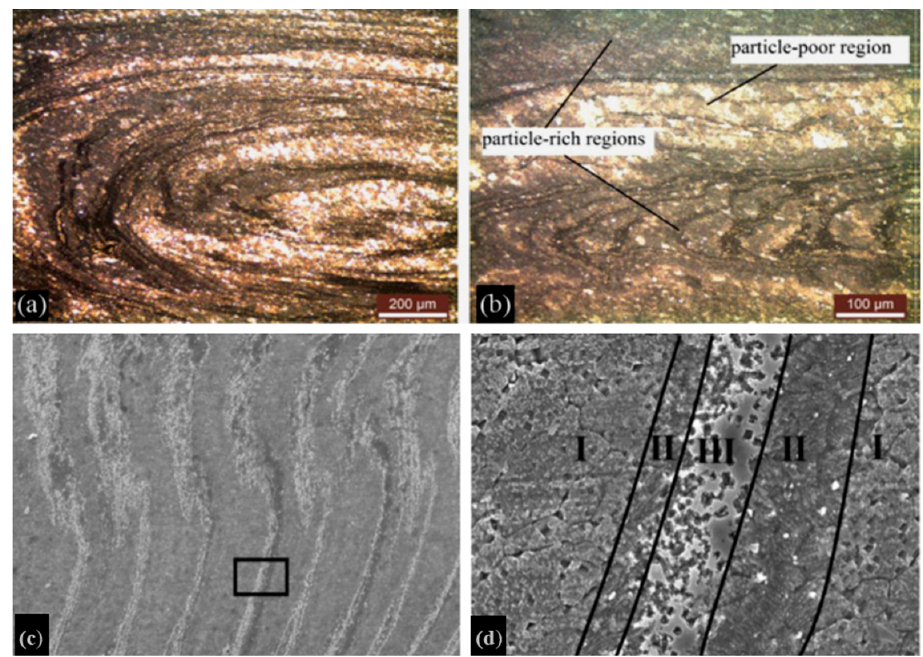
Figure 16. Microscopic image of the ( a ) center and ( b ) advancing side in weld nugget ( c ) concentric region and ( d ) area division in concentric region showing SiC rich and poor regions [32] .